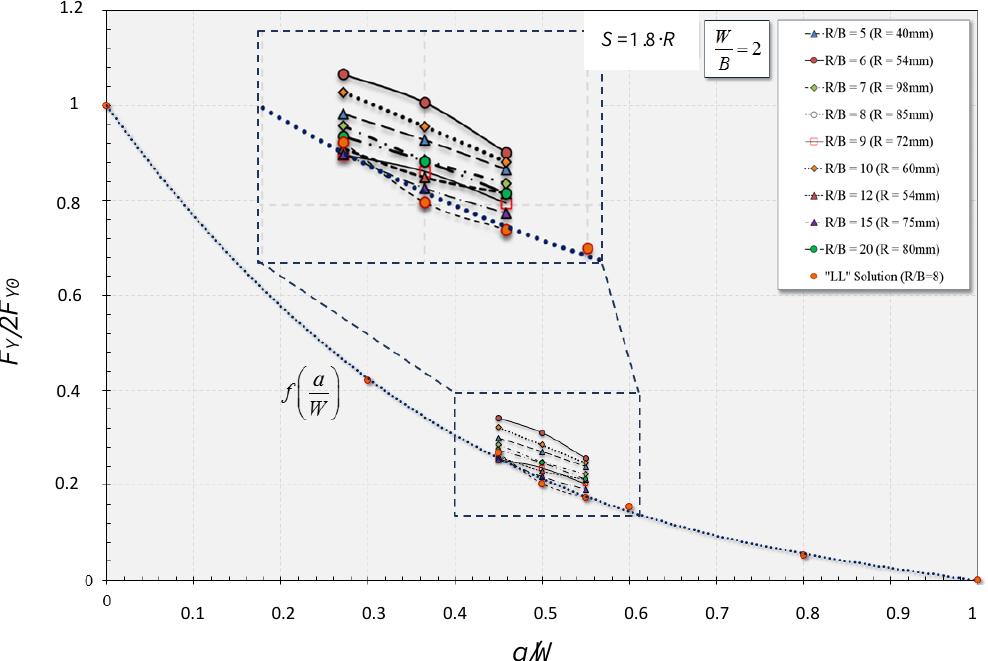
Figure 12. Comparison of matching the limit load function of R / B = 8 with other ring sizes in the range of the standard crack aspect ratio a / W = 0.45 to 0.55 [4–7].